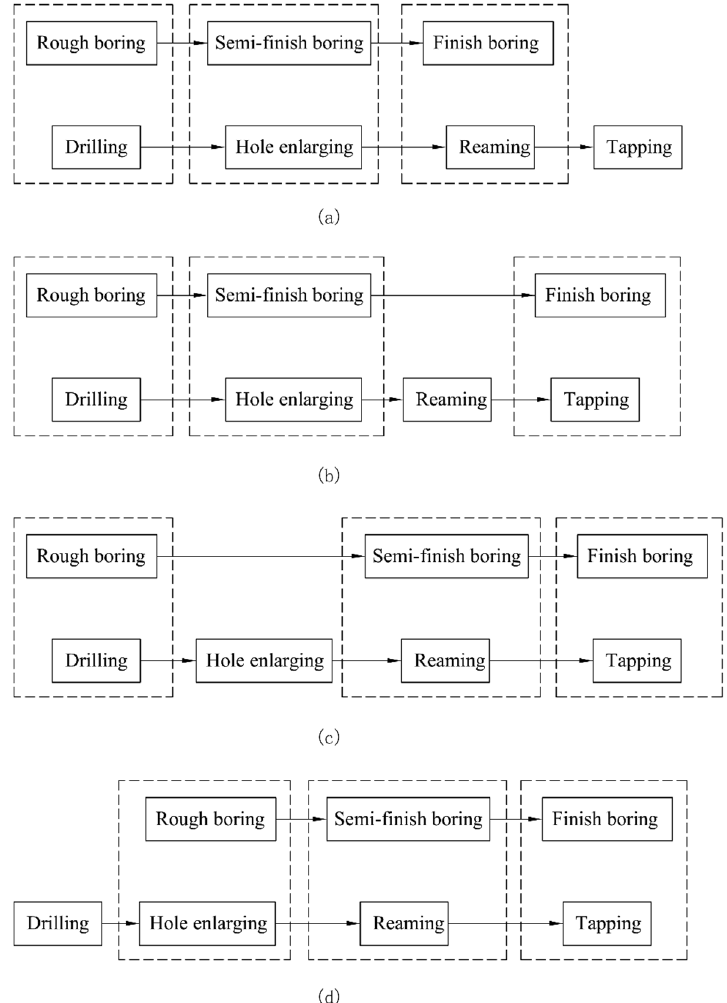
Figure 8. The processing units obtained by the combination of the natural combination process units without homologous relationships: ( a ) Get the first case of multiple processing units ( b ) Get the second case of multiple processing units ( c ) Get the third case of multiple processing units ( d ) Get the fourth case of multiple processing units.